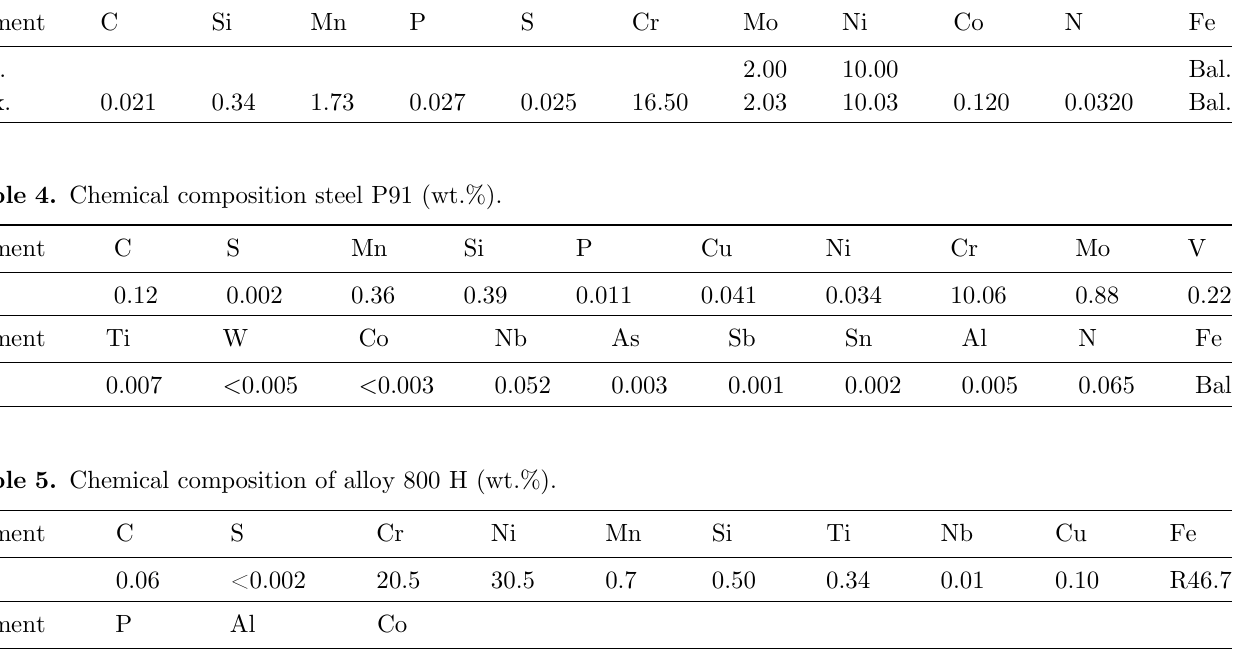
Table 3. Chemical composition of steel 316 L (wt.%). Element